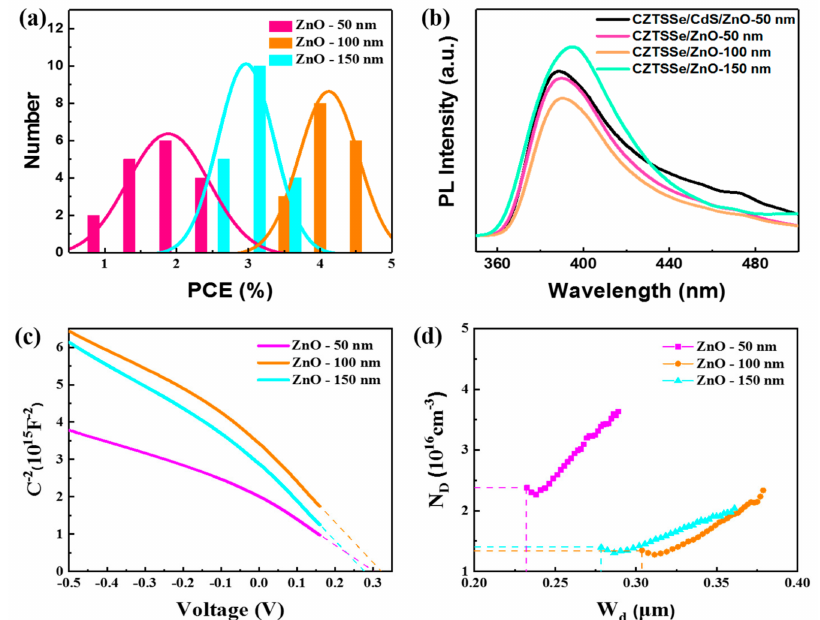
Figure 2. ( a ) The statistical PCE histogram of the flexible CZTSSe solar cells with ZnO layers with different thicknesses. ( b ) PL quenching spectra of the different buffer layers based on CZTSSe absorbers. ( c , d ) The C-V characteristics of the devices: ( c ) C − 2 -V and ( d ) N D -W d